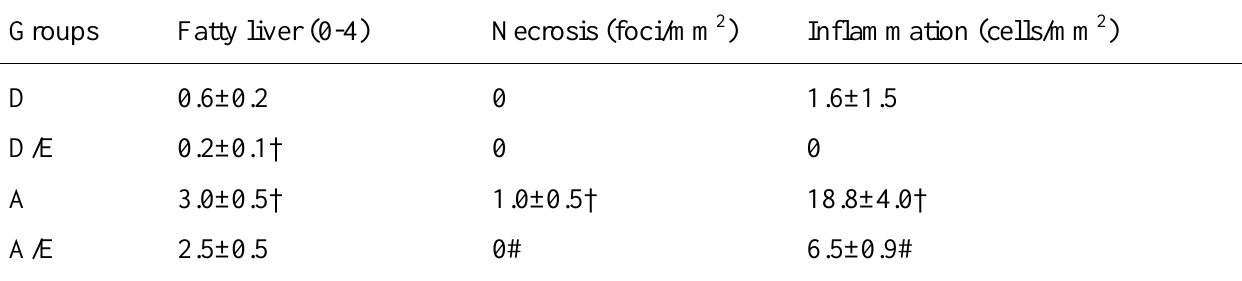
Table 2. Hepatic pathological scores in the different experimental